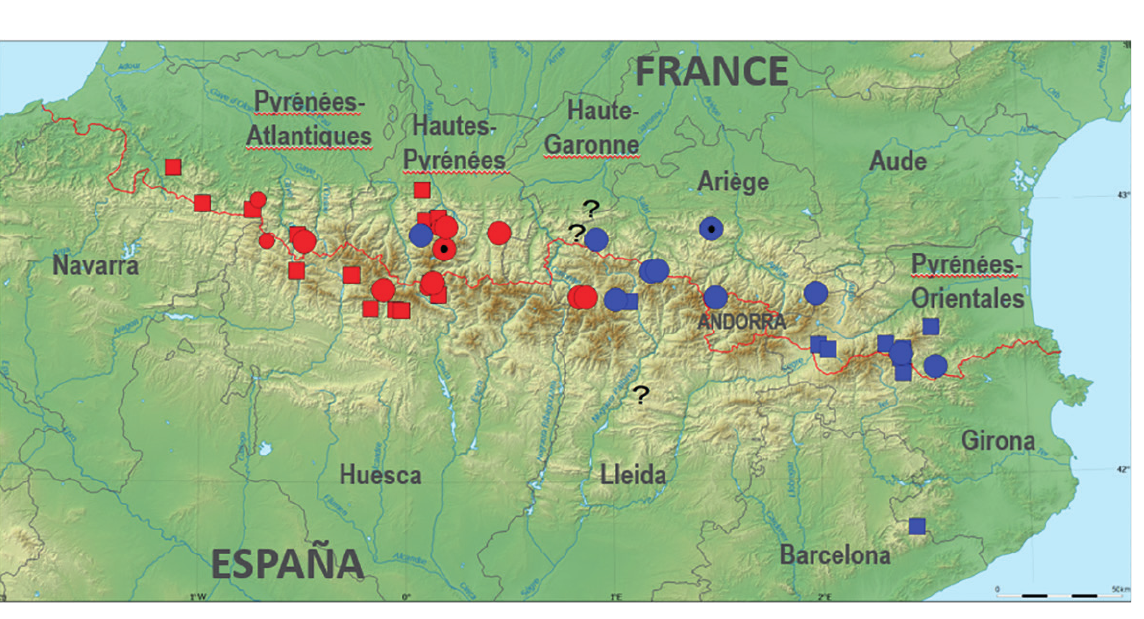
L ength . 2.7, width of prosoma 1.8, BLI 1.4 (CJM 2649).